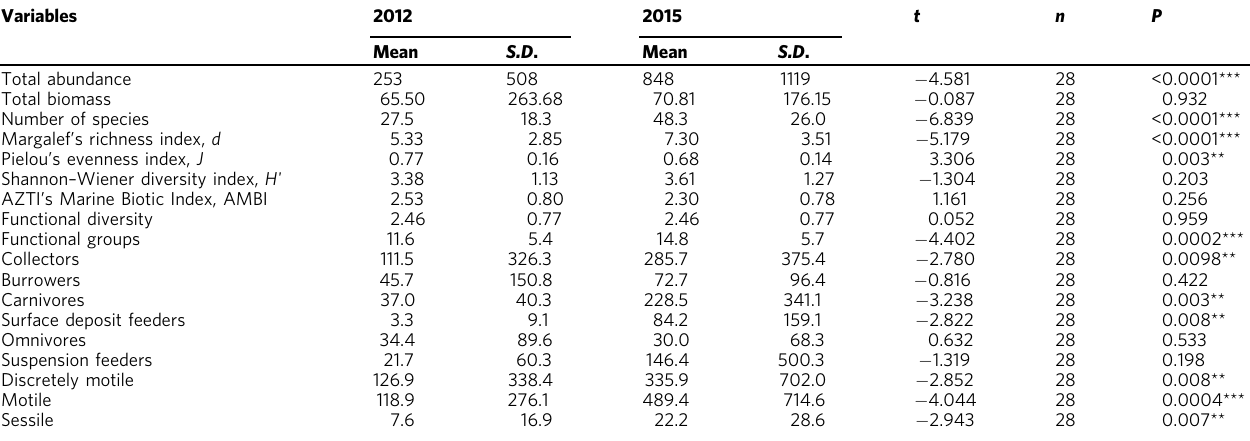
Table 1 Comparison in biotic variables before (2012) and after (2015) the trawl ban in surveyed 28 sites in Hong Kong waters. Variables Total abundance